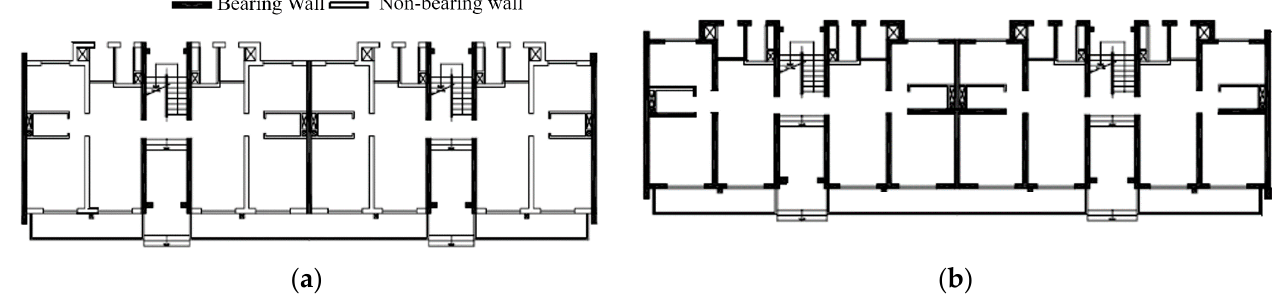
Figure 1. Apartment structure plans. ( a ) without seismic design; ( b ) with seismic design.